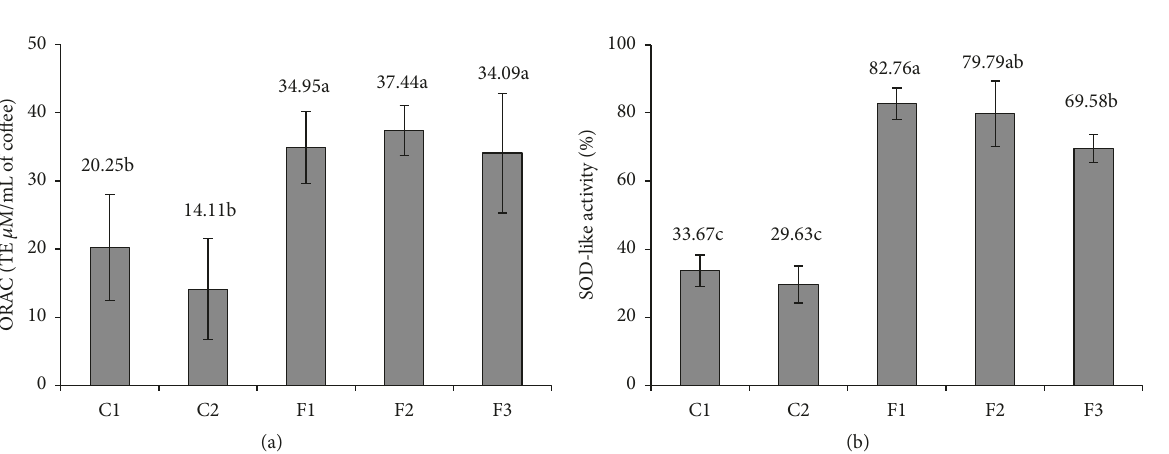
C2, F1, F2, and F3 were 2.567, 2.507, 2.469, and 2.673